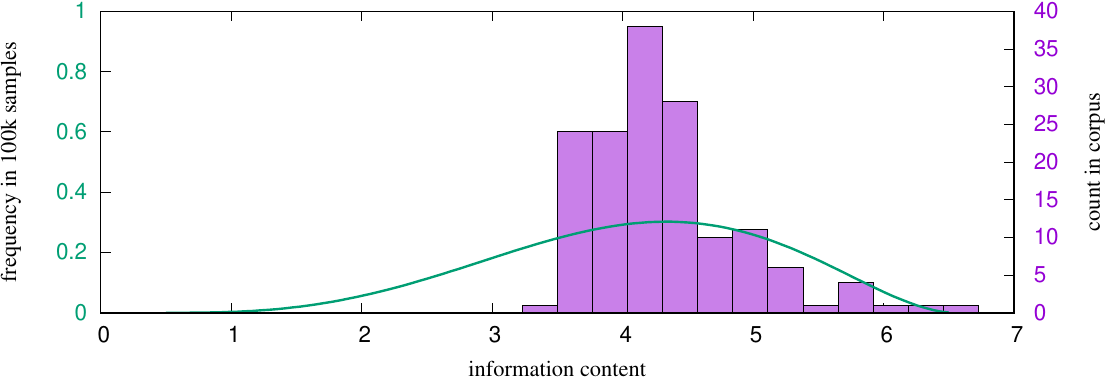
Figure 2. For the pattern X { 8 } + , the probability density of information content estimated from 100,000 samples (curved), and the information content of the 150 corpus sequences (histogram).